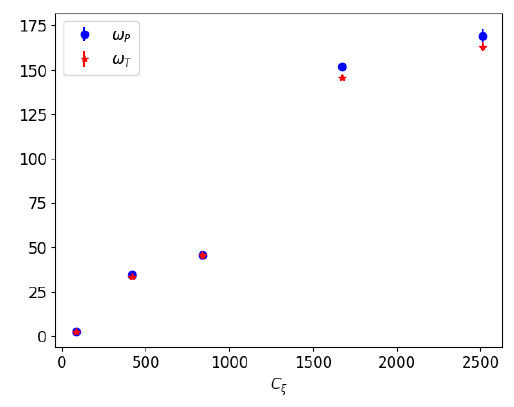
Figure 3. Dependence of growth rates ω P (blue squares) and ω T (red stars) on the dynamo number C ξ . Values in ms − 1 along the vertical